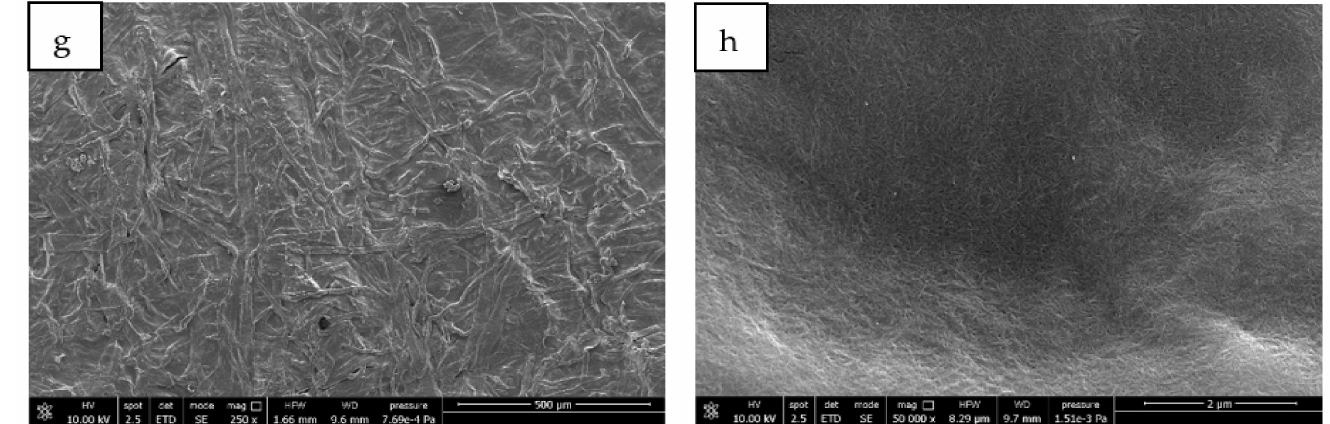
Figure 12. FESEM micrographs of: ( a ) polyphenols and ( b ) chitin sprayed on aluminium foil, ( c , d ) paper tissue, ( e , f ) paper tissue treated with polyphenols, and ( g , h ) paper tissue treated with